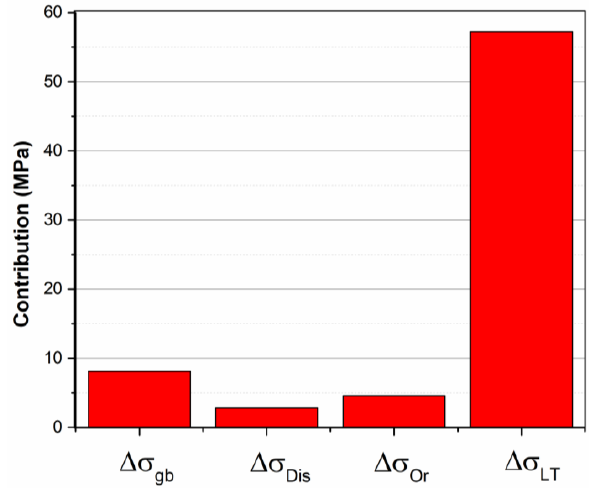
Figure 12. Contribution of the strengthening mechanisms on the yield strength of the nanocomposites.